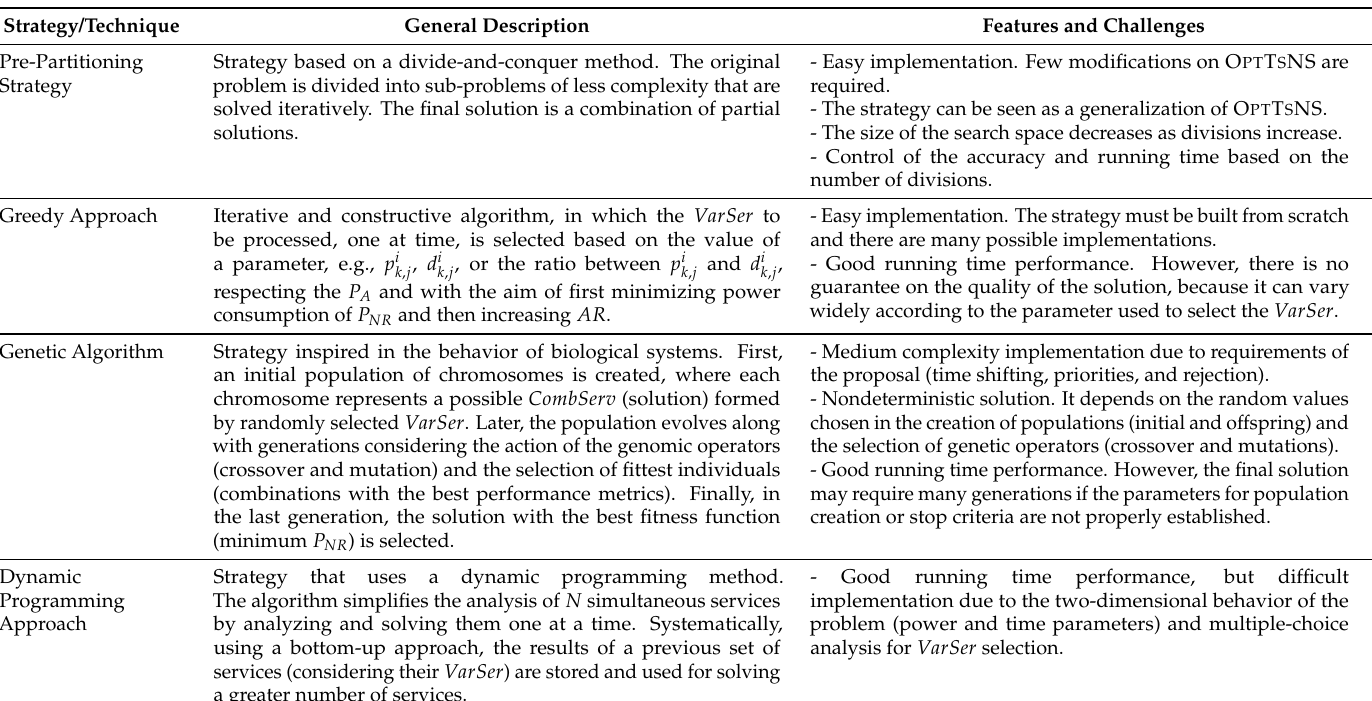
Table 7. Heuristics strategies analyzed to solve the P NR minimization problem